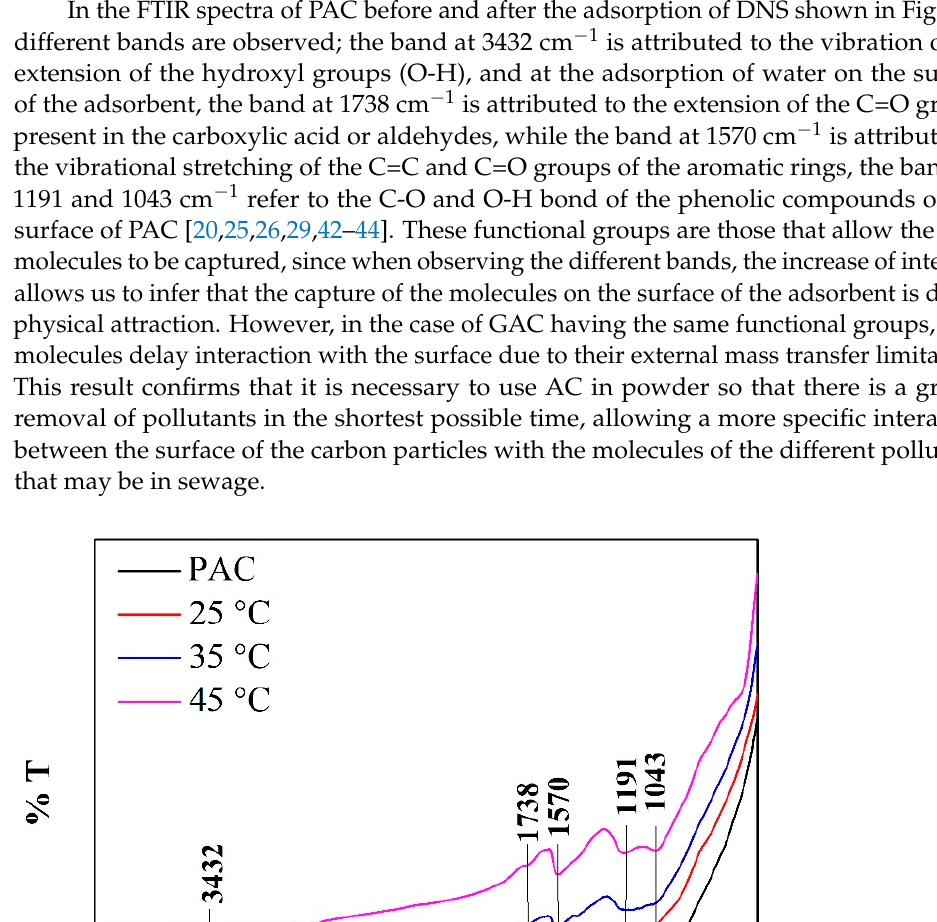
Table 7. Physicochemical properties and elemental analysis of PAC [45,46].